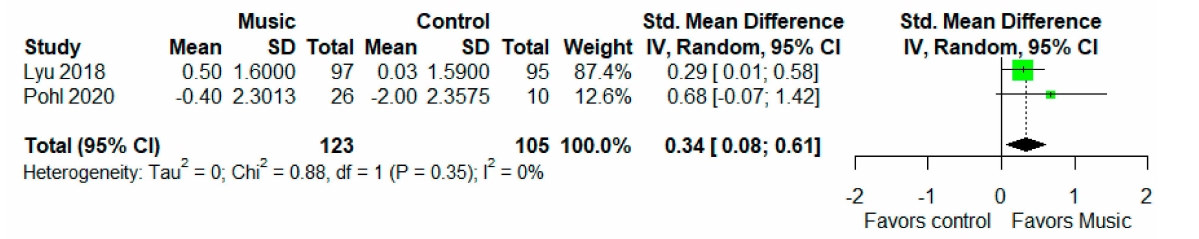
Figure 4. Trial level data, effect estimates, and forest plot for the effects of music-based intervention on the AVLT. The area of green square is proportional to the study’s weight in the meta-analysis.